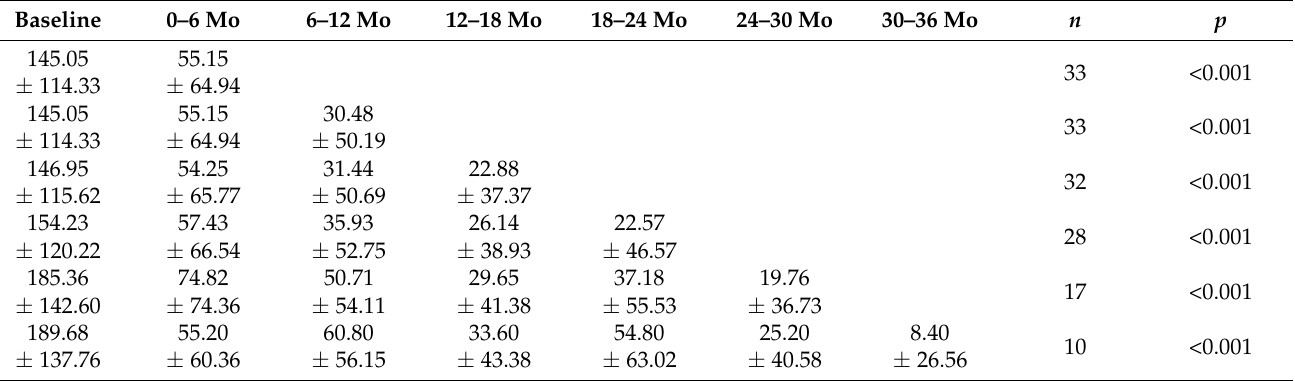
Table 2. Dosage of oral systemic steroid (methylprednisolone, mg) (repeated ANOVA